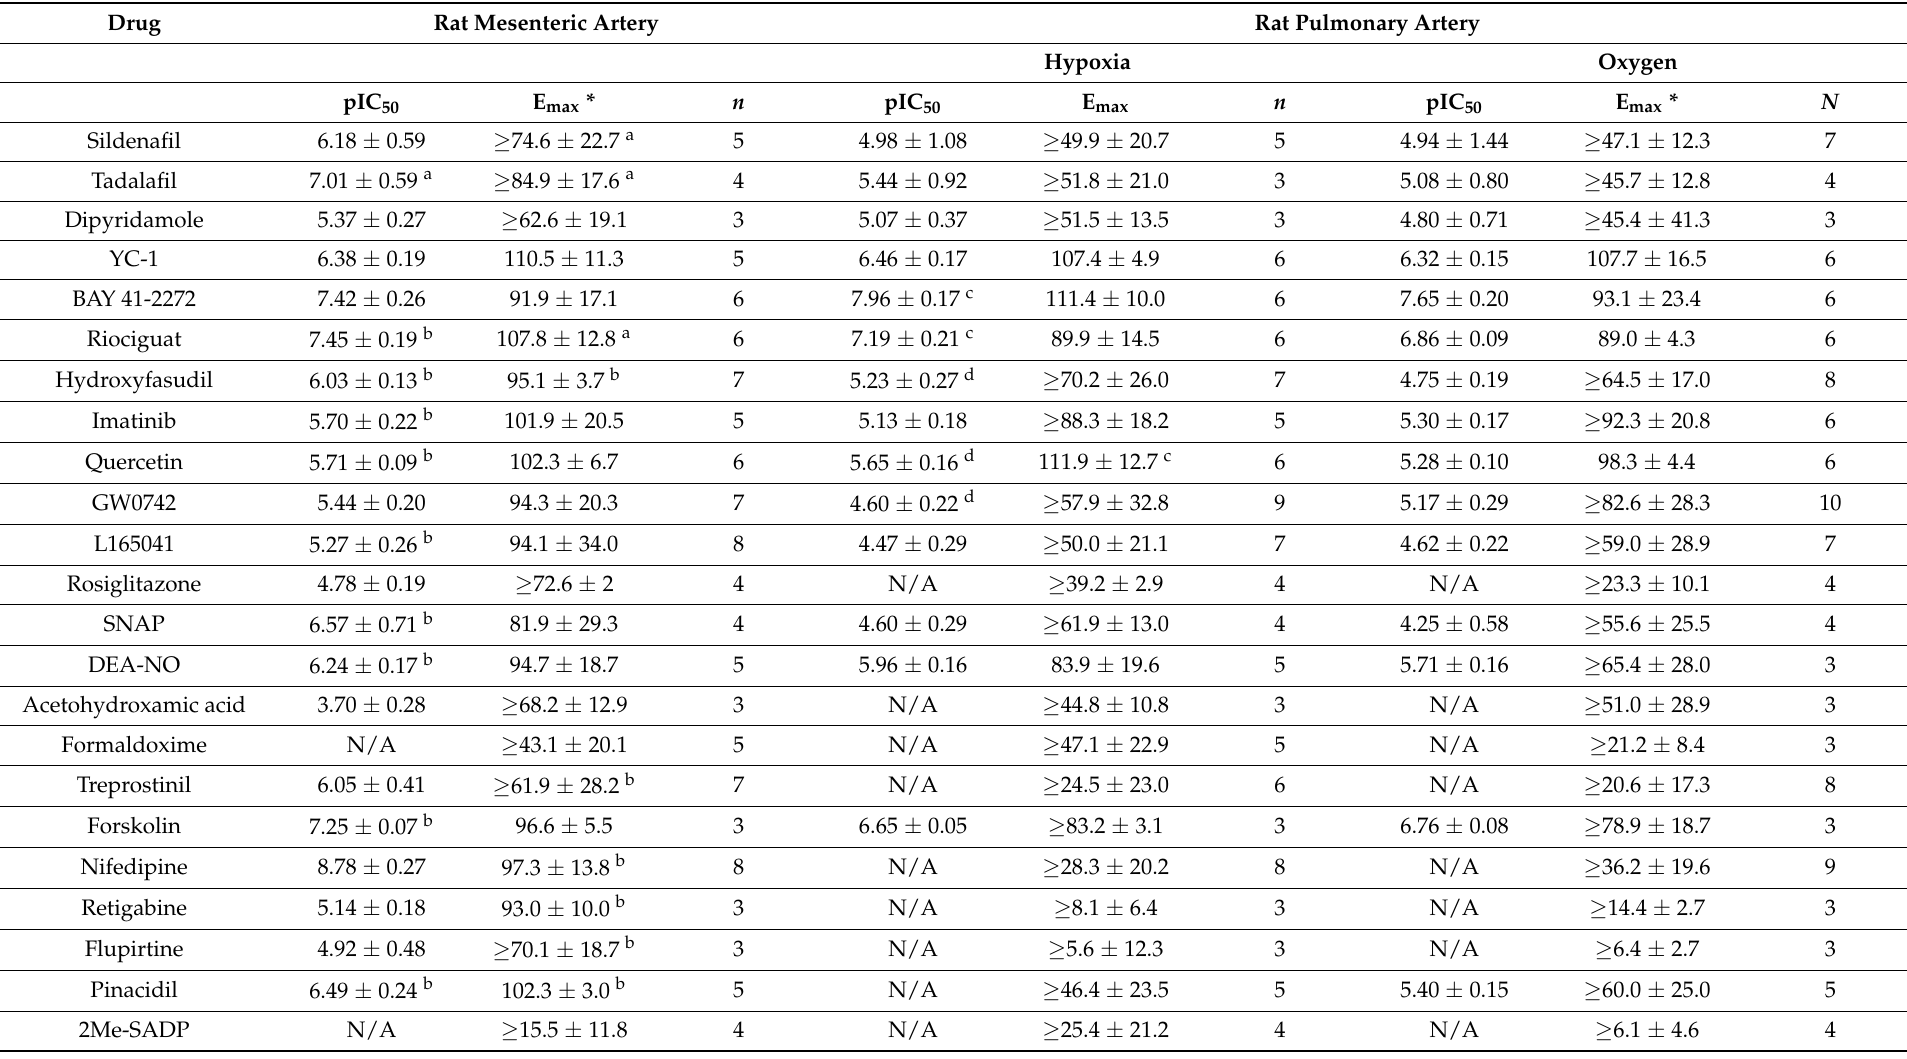
Table 1. Parameters derived from the concentration-response curves in rat pulmonary and mesenteric